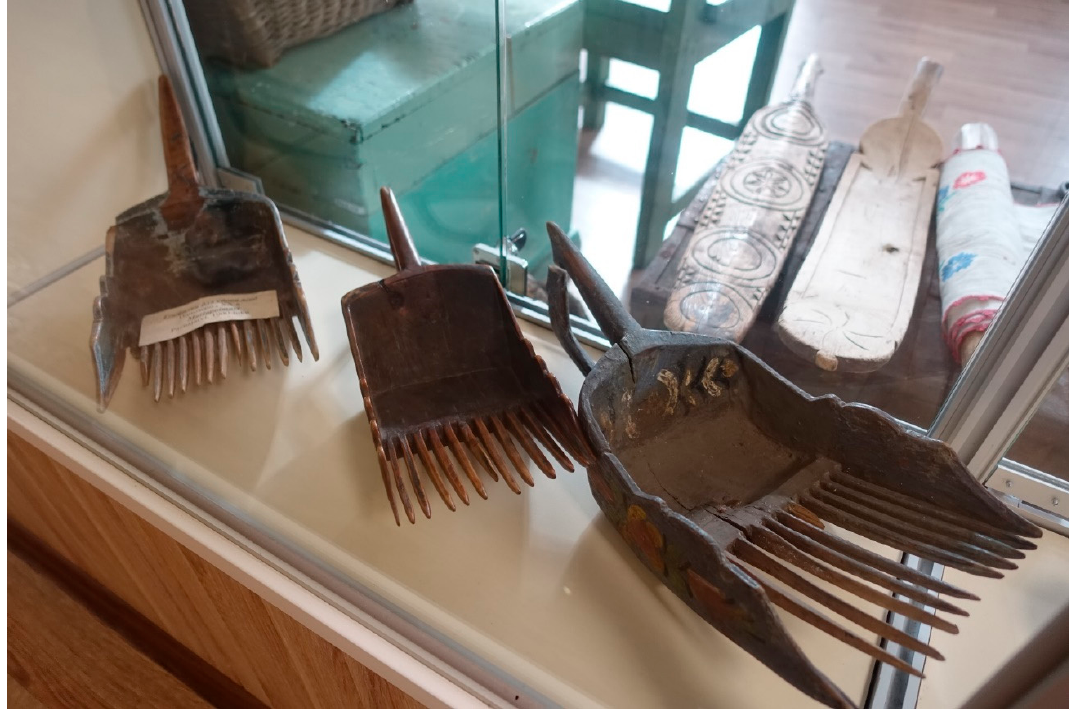
Figure 8. Wooden ‘kombains’ in Ethnographic museum of rune singers, Kalevala.